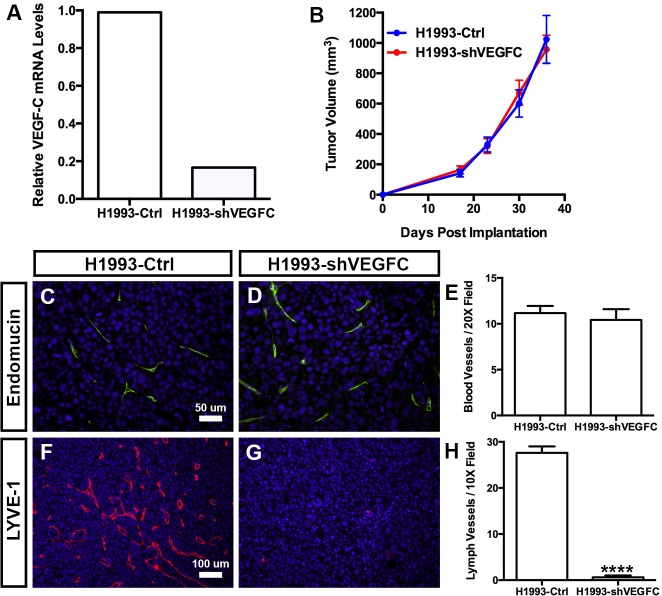
Knockdown of VEGF-C inhibits tumor lymphangiogenesis.(A) qPCR results showing that H1993-shVEGFC cells express a lower level of VEGF-C than H1993-Ctrl cells. (B) Tumor growth curves for mice injected subcutaneously with either H1993-Ctrl or H1993-shVEGFC cells. (C,D) Representative images of H1993-Ctrl and H1993-shVEGFC tumor sections stained with an anti-endomucin antibody. (E) The number of blood vessels per microscopic field is not significantly different between H1993-Ctrl tumors (11.17 ± 0.7817, n = 6) and H1993-shVEGFC tumors (10.42 ± 1.182, n = 7). (F,G) Representative images of H1993-Ctrl and H1993-shVEGFC tumor sections stained with an anti-LYVE-1 antibody. (H) The density of intratumoral lymphatic vessels is significantly lower in H1993-shVEGFC tumors (0.61 ± 0.400, n = 7) than H1993-Ctrl tumors (27.61 ± 1.391, n = 6). **** P < 0.0001.